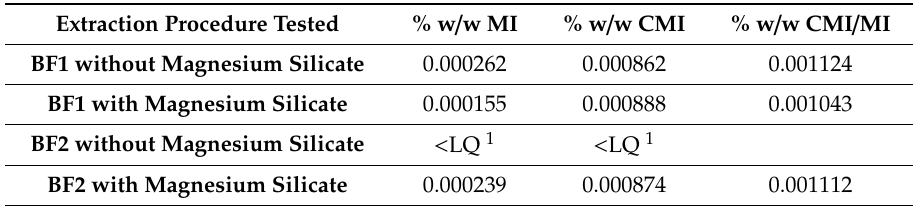
Table 2. Extraction of the CMI / MI mixture in the base formulations with and without magnesium silicate addition in extraction procedure